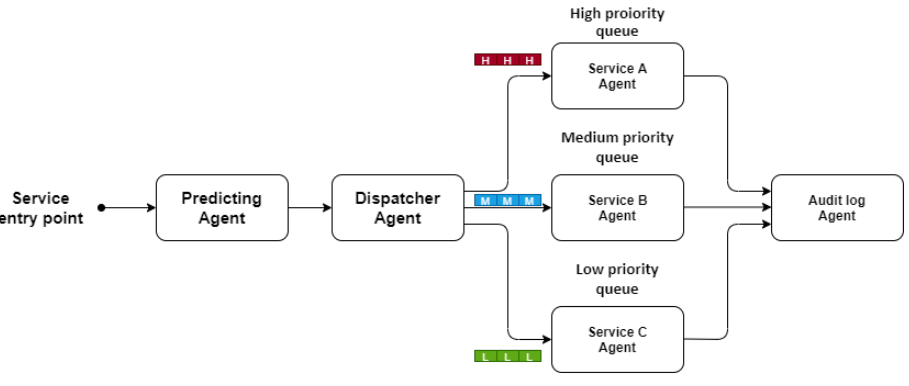
Figure 6. Simple architecture for the